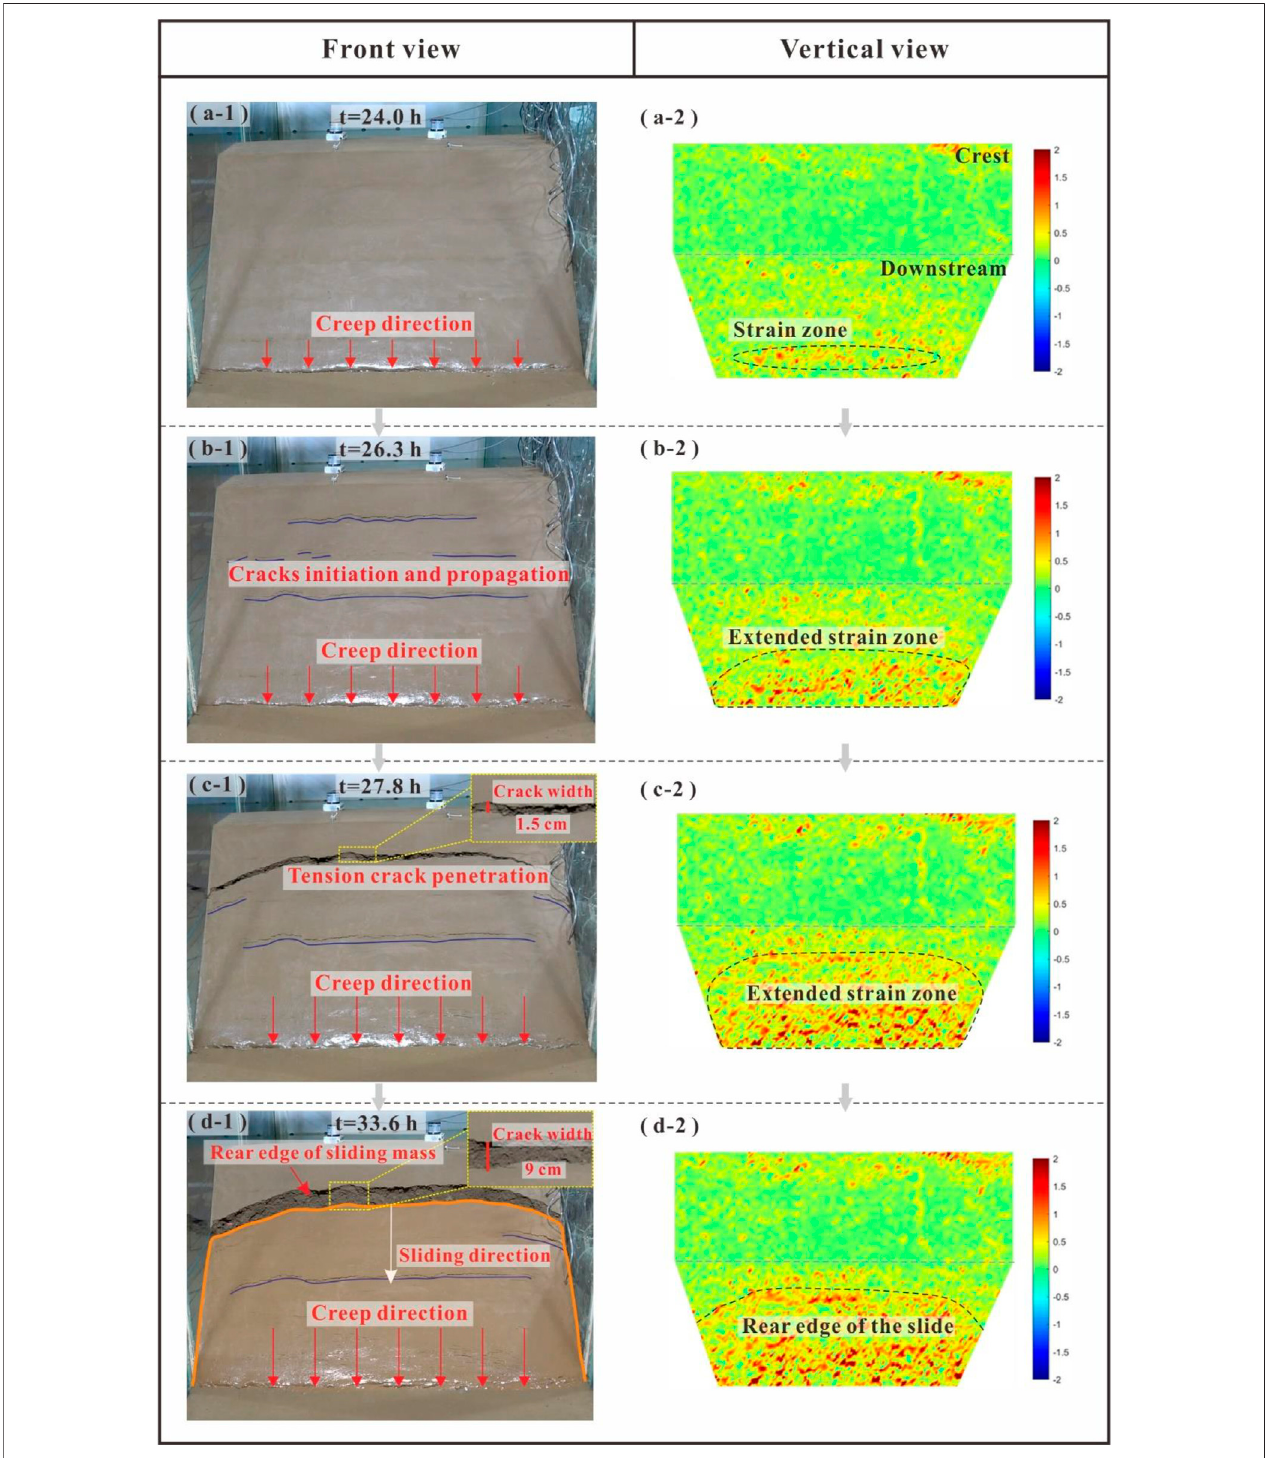
FIGURE 8 | Progressive process of the fi rst slide from front view and vertical view. (A) Creep at the dam toe, (B) crack initiation and propagation, (C) crack penetration, and (D) sliding.